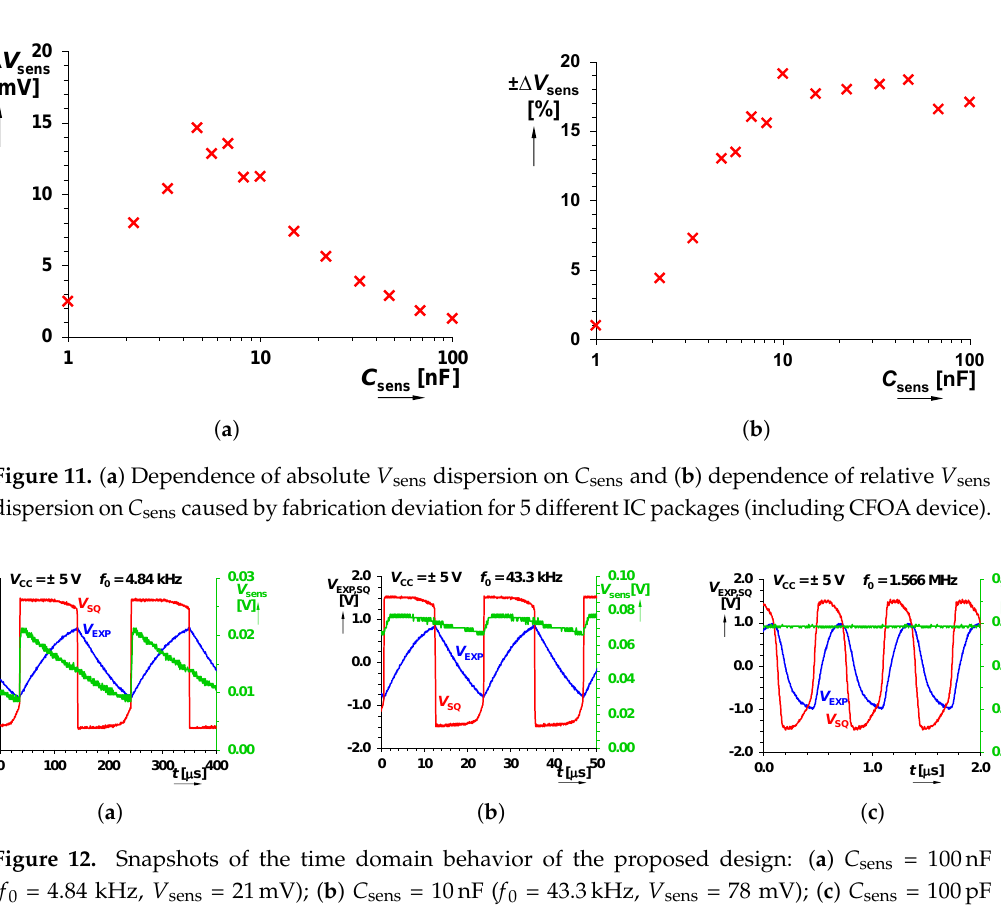
Figure 10. ( a ) Dependence of absolute f 0 dispersion on C sens and ( b ) dependence of relative f 0 dispersion on C sens caused by fabrication deviation for 5 different IC packages (including CFOA device).